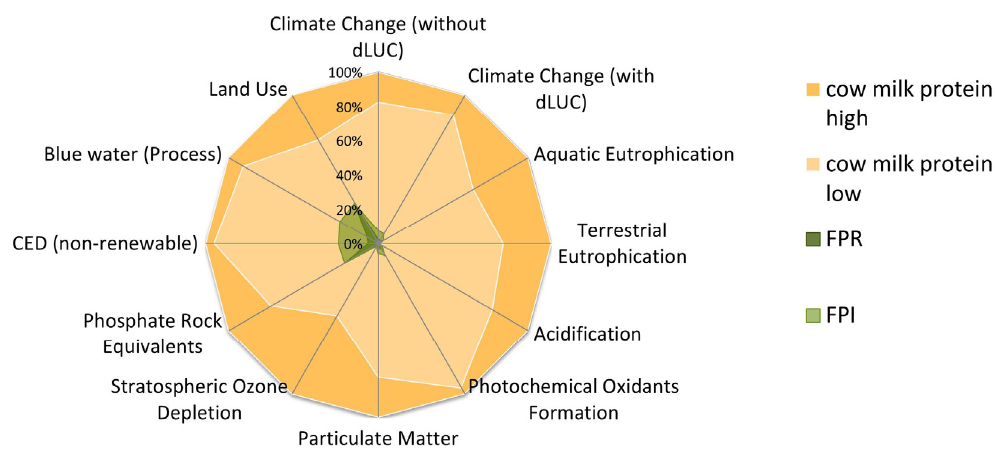
Figure 12. Comparison of environmental impact profiles of FPR and FPI, versus cow’s whole milk powder ranges per kg protein. The highest result is set to 100%; dLUC: direct land use change.